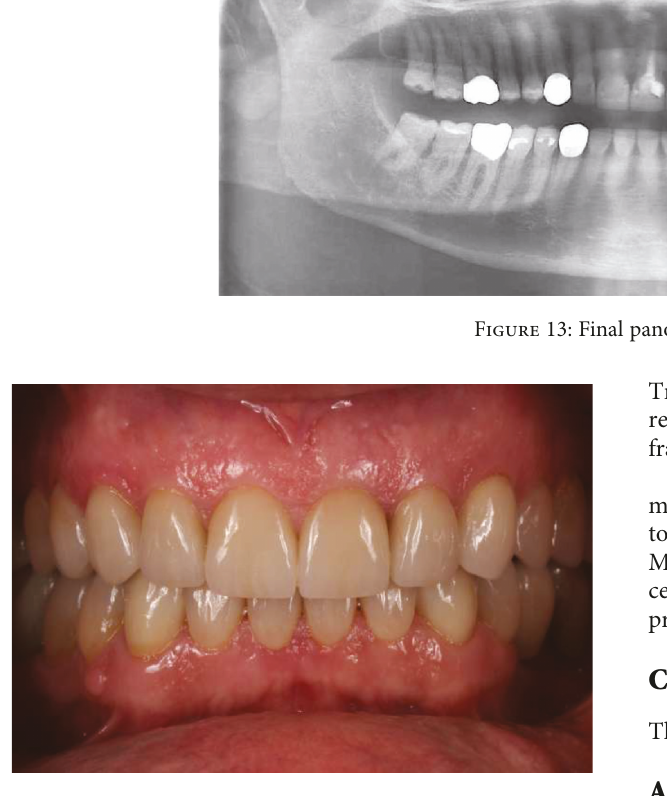
Figure 14: Intraoral frontal view after 48 months.